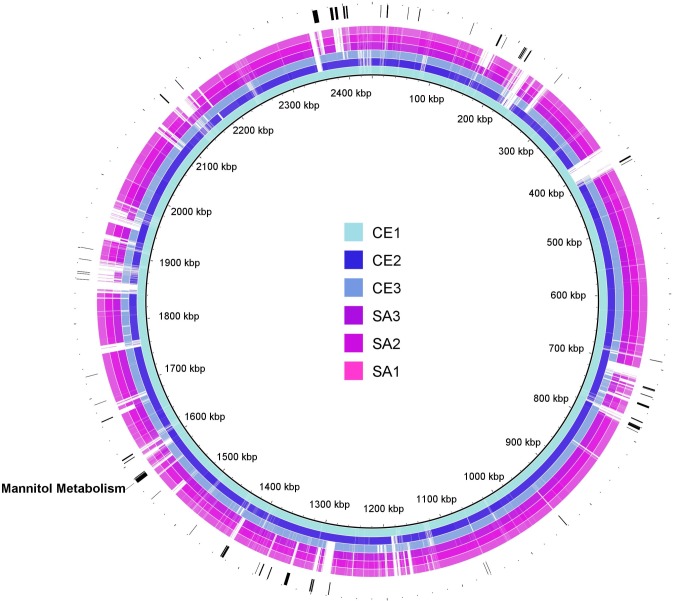
Predicted Proteins Conserved in Commensal EC Mapped to Genome Assemblies of EC.Pathogenic (magenta) and commensal (blue) EC scaffolds were mapped to CE1 (including CE1 as a control) using BRIG ring generator and BLASTn. Genetic sequences of less than 50% homology are plotted in white on each ring. Outside the chromosomal rings and identified by green bars, are the genomic locations of the 95 predicted proteins with >90% identity in commensal strains and with <90% identity in pathogenic strains. Genomic predicted proteins involved in mannitol metabolism are labeled in black.